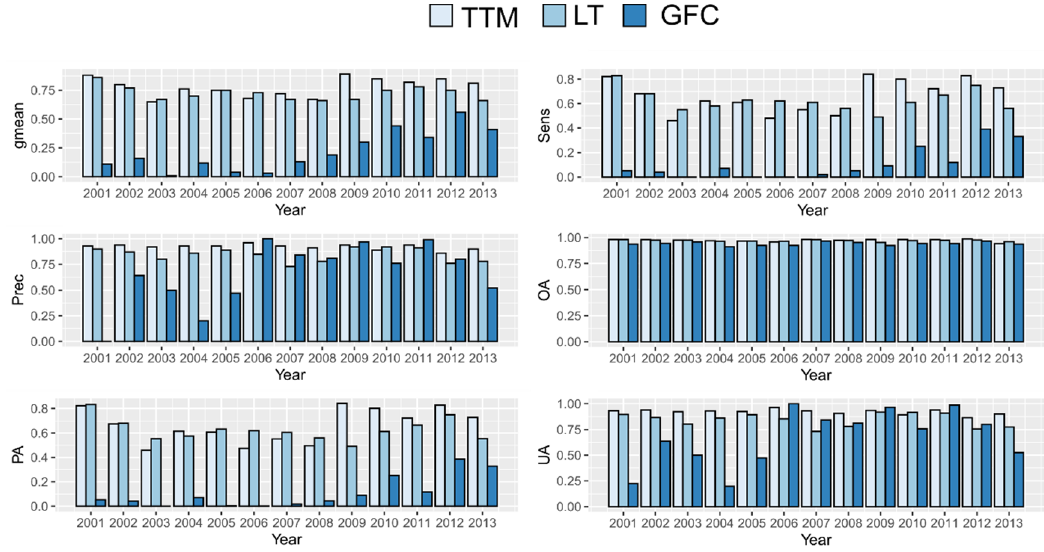
Figure 5. Accuracy estimates based on confusion matrices constructed using the validation dataset for the three quadrats. The vertical axis represents the accuracy indices (gmean = g mean accuracy index, Sen = sensitivity, Prec = precision, OA = Overall Accuracy, PA = Producer Accuracy of clearcut class, UA = Users Accuracy of clearcut class).